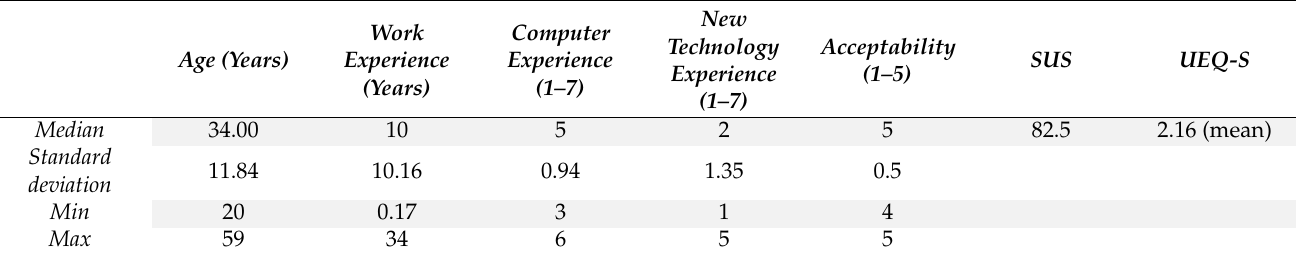
Table 1. Summary of user experience